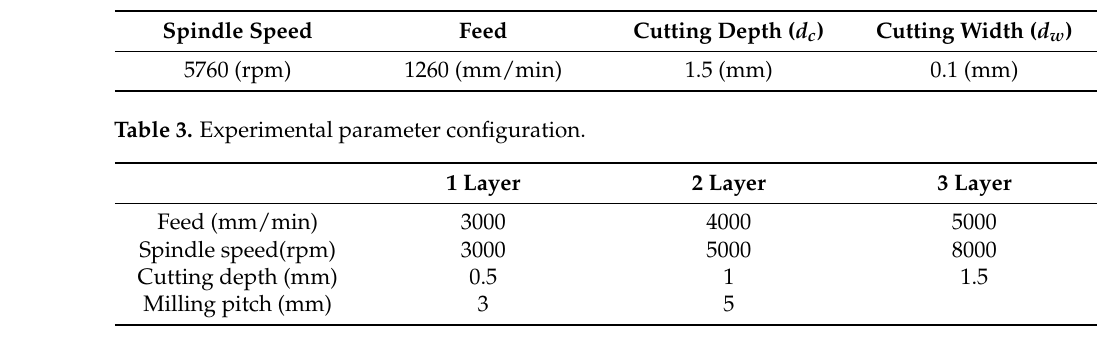
Table 2. S220 CEXSH31000 end mills milling parameter recommended value.